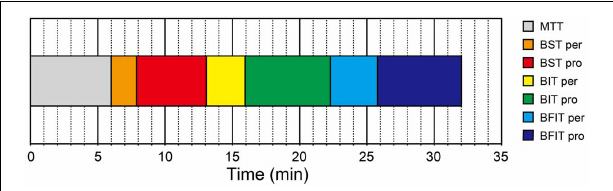
FIGURE 9 | Testing duration of the Harvard Beat Assessment Test (H-BAT). MTT, music tapping test; BST per, perception part of beat saliency test; BST pro, production part of beat saliency test; BIT per, perception part of beat interval test; BIT pro, production part of beat interval test; BFIT per, perception part of beat finding and interval test; BFIT pro, production part of beat finding and interval